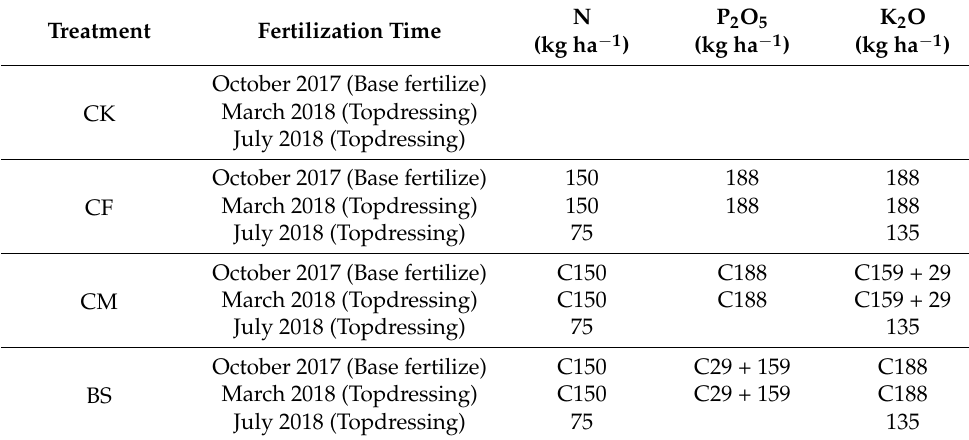
Table 1. Fertilizer application procedure of different treatments.